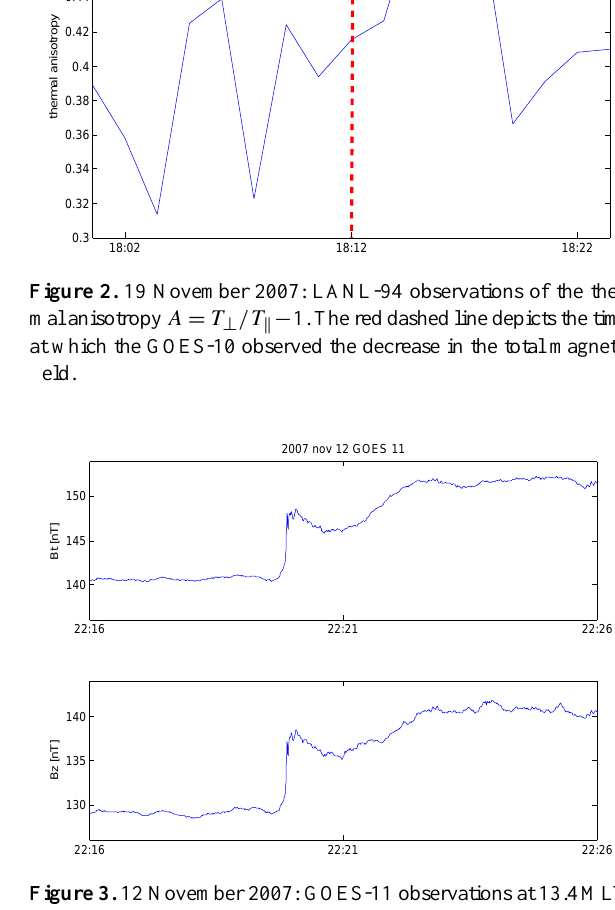
Fig. 2. 19 November 2007: LANL-94 observations of the thermal anisotropy A = T ⊥ /T k -1. The red dashed line depict the time when the GOES-10 observed the decrease in the total magnetic field.